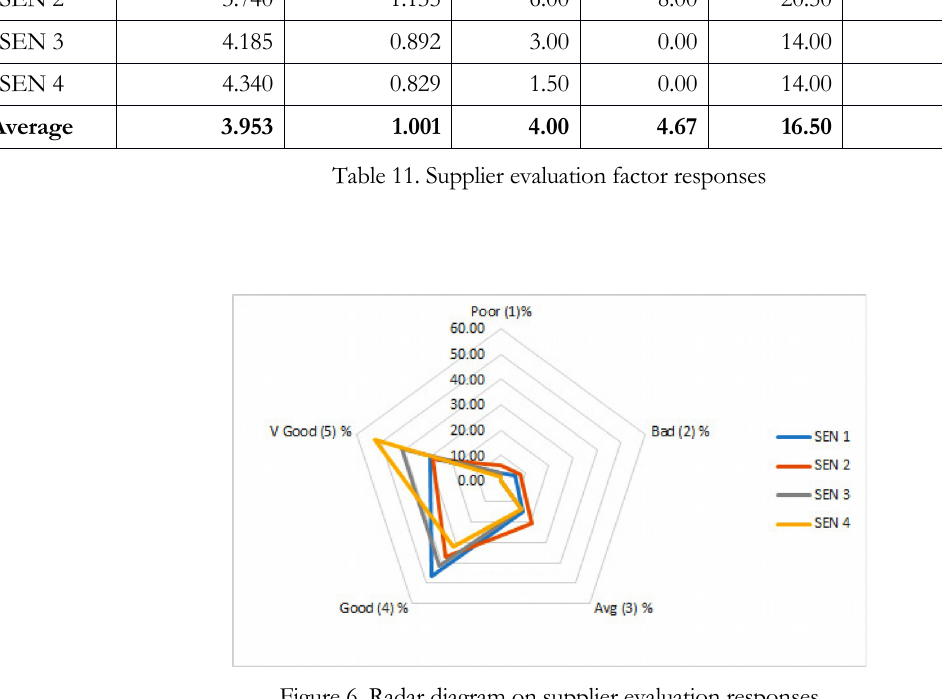
Figure 6. Radar diagram on supplier evaluation